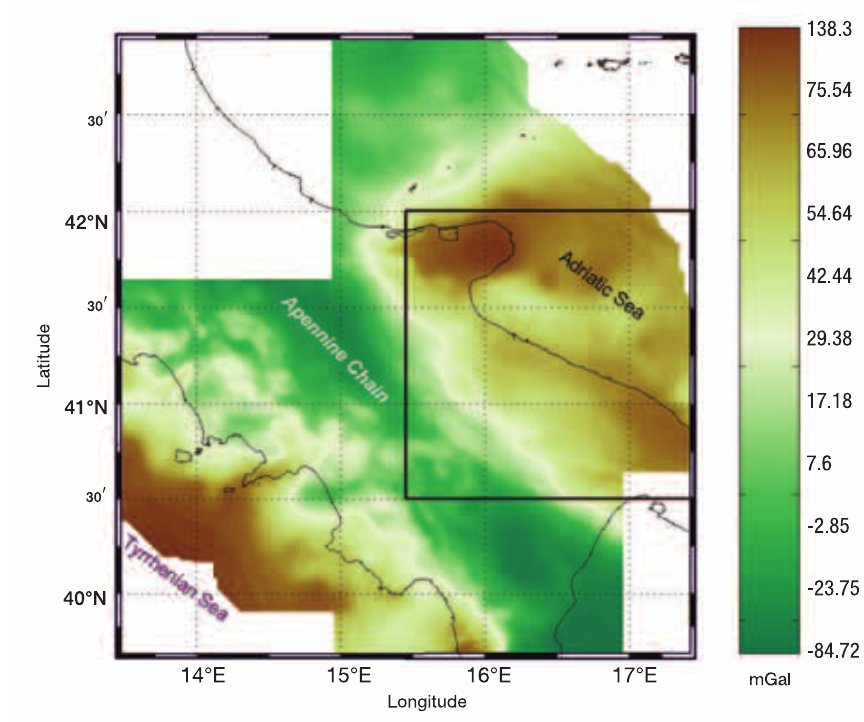
Fig. 3. Bouguer gravity anomaly field in the Central-Southern Italy. Grid step = 1